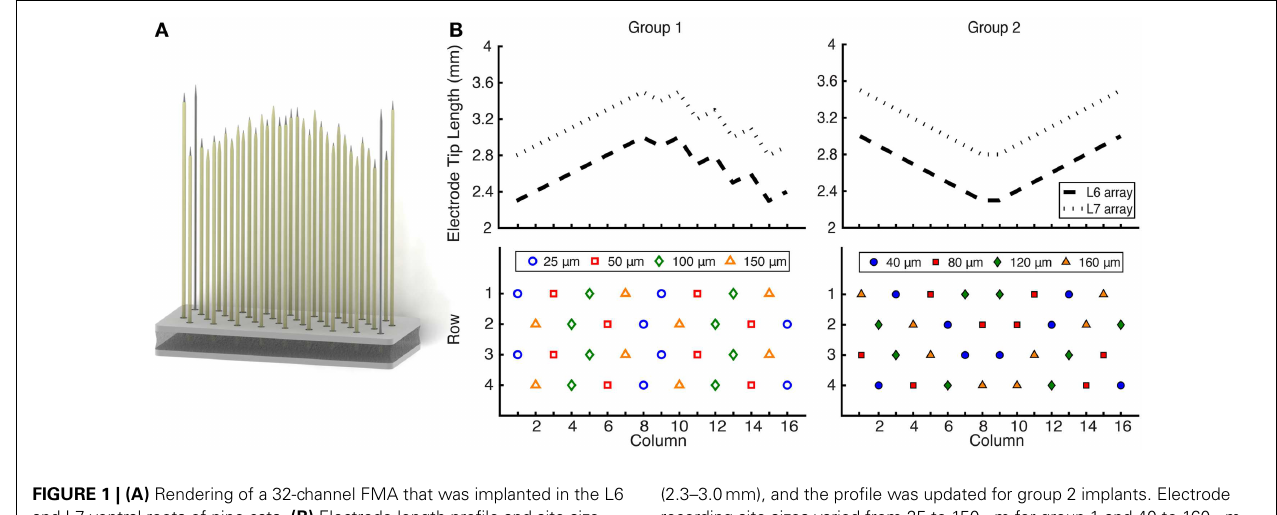
FIGURE 1 | (A) Rendering of a 32-channel FMA that was implanted in the L6 and L7 ventral roots of nine cats. (B) Electrode length profile and site size layout.The electrode lengths were customized to reach the ventral root through the DRG. L7 arrays (2.8–3.5mm) were longer than L6